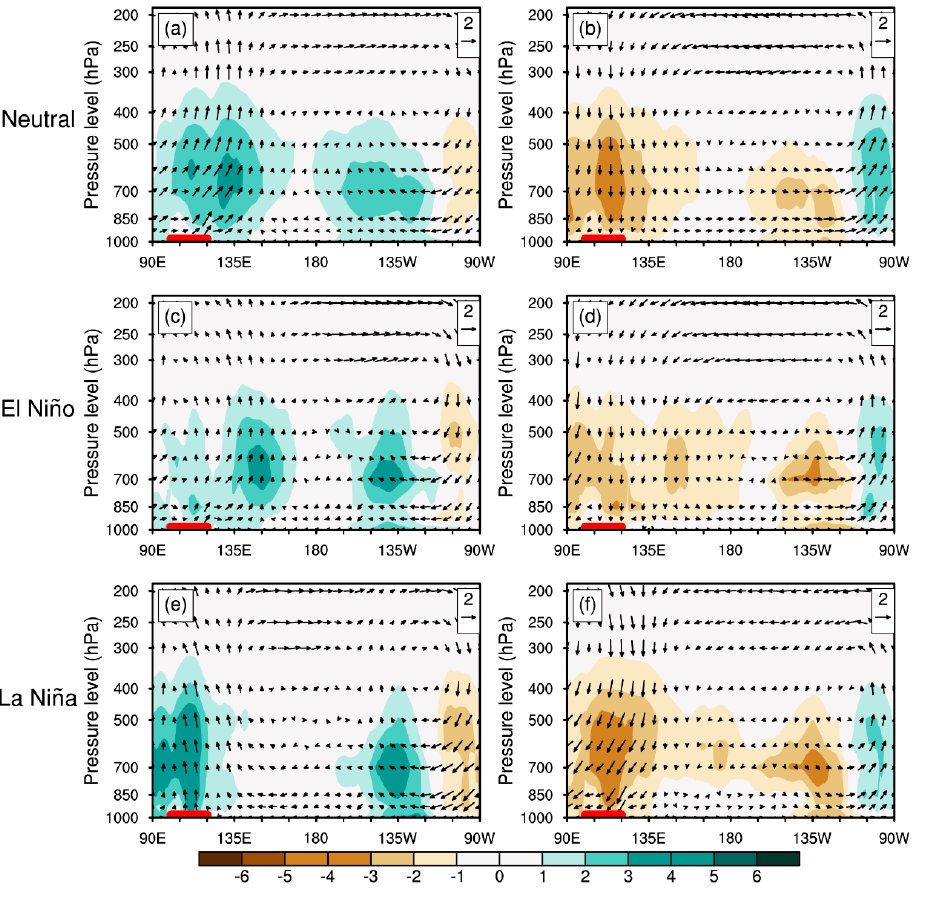
Figure 8. Composite longitude-height section of filtered wind anomalies (vectors; unit: m·s − 1 ) and filtered specific humidity anomalies (shaded; unit: 10 − 1 g·kg − 1 ) averaged over 10° N–20° N in the (left) active and (right) inactive MJO phases for ( a , b ) neutral, ( c , d ) the El Niño, and ( e , f ) the La Niña years during June–November over the period of 1979–2016. Thick red line on abscissas is the SCS location. The definition of the active and inactive phases for the MJO-related SCS TC genesis under different ENSO conditions is in Table 1.